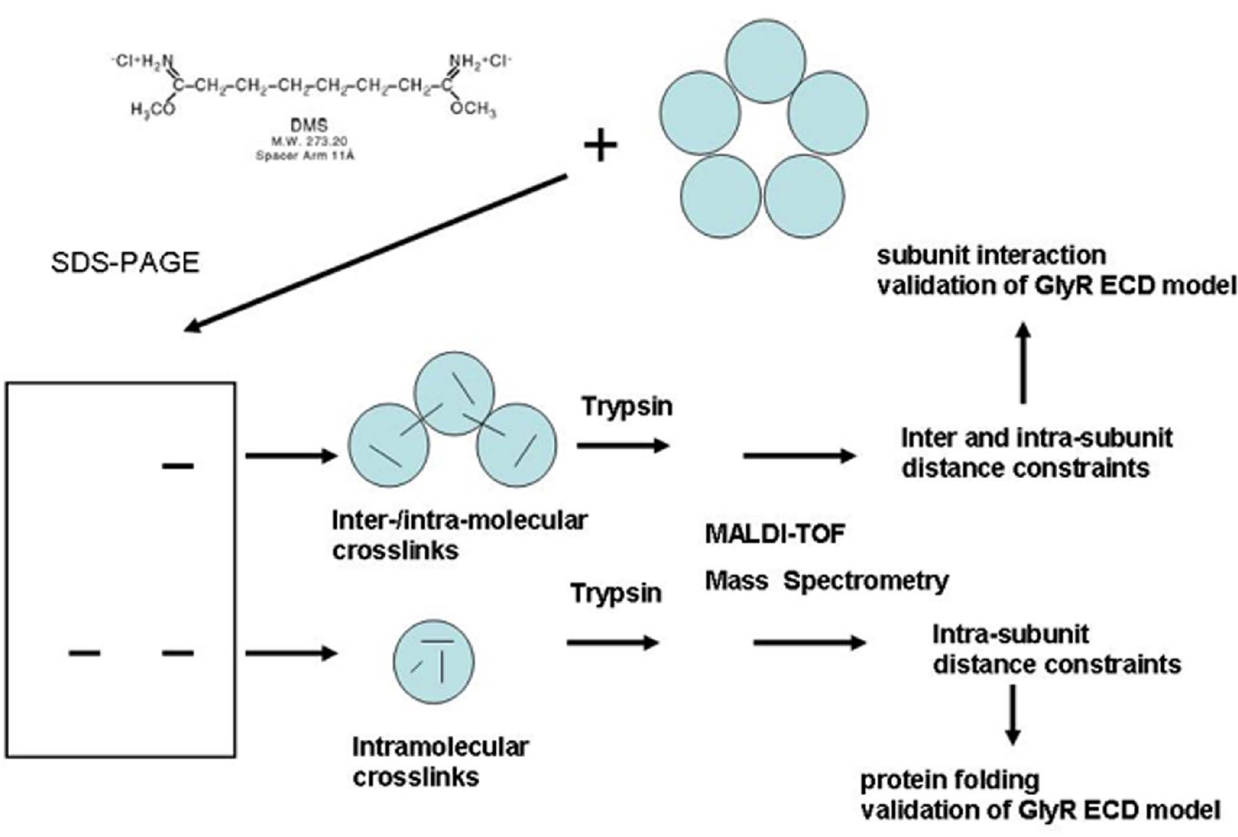
Figure 3. Overview of experimental strategy used in MS/GlyBP modeling studies.